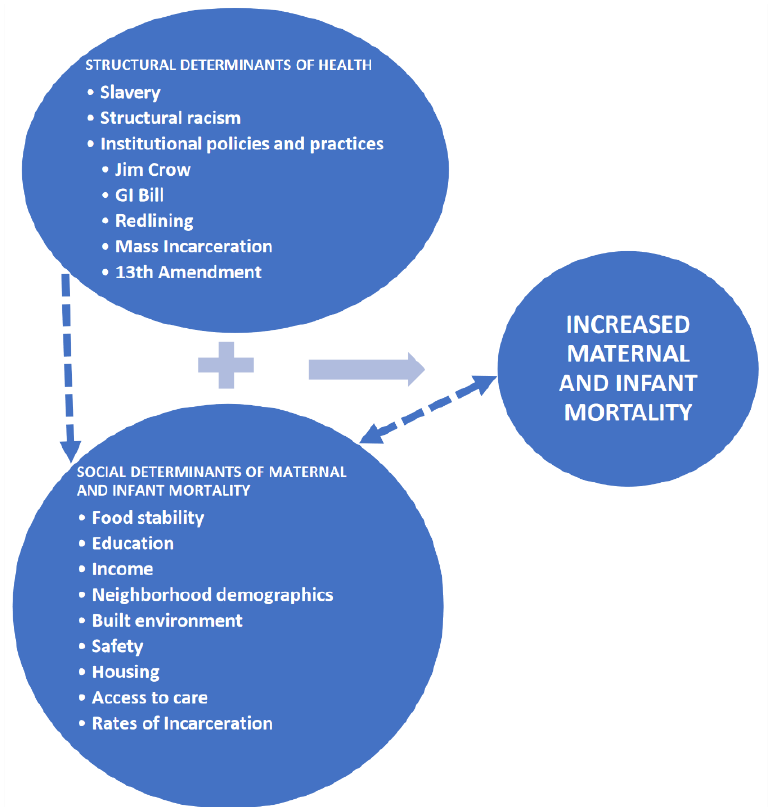
Figure 1. Application of Theoretical Framework on Structural and Social Determinants of Maternal and Infant Mortality in the United States.